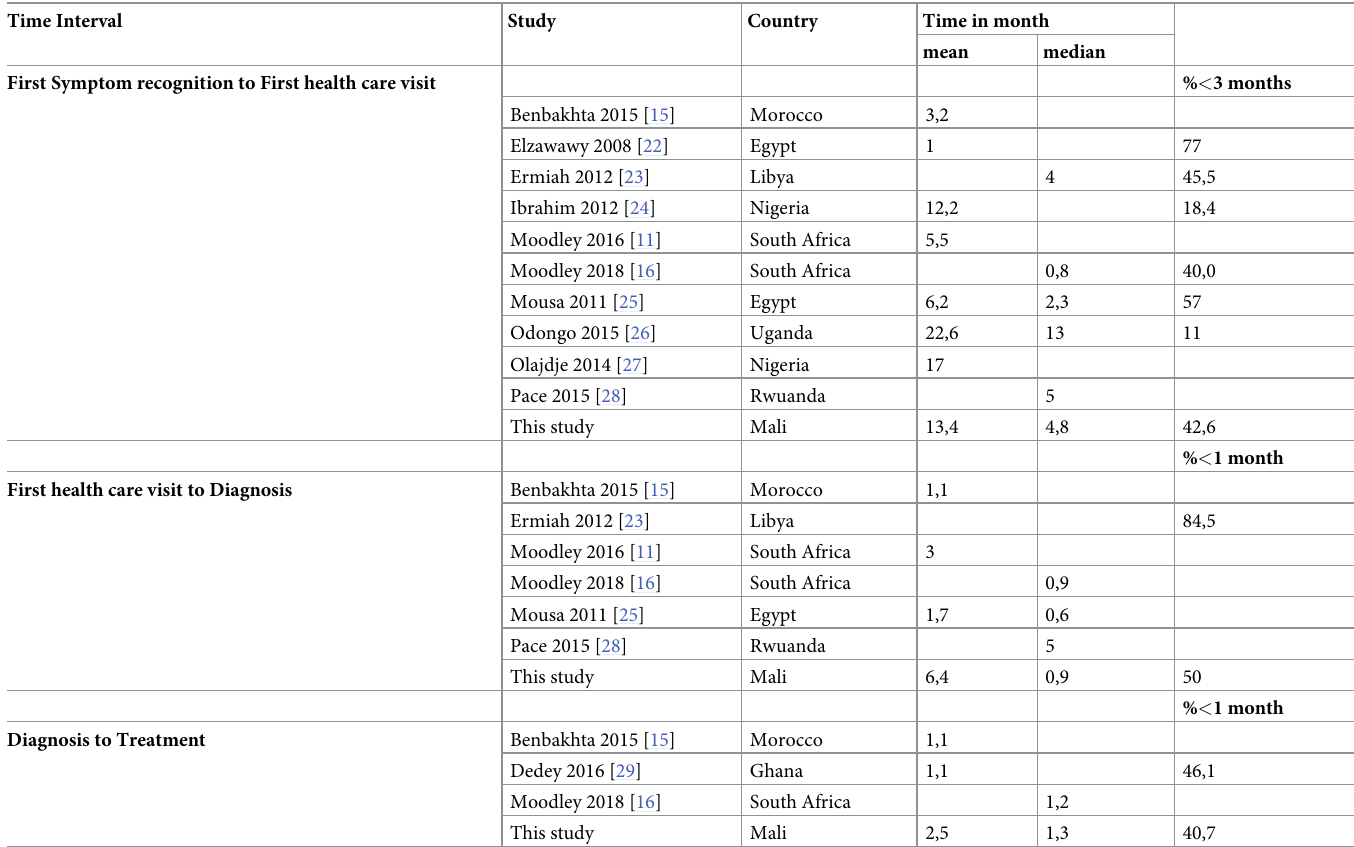
Table 3. Comparisons of time to first health care visit, diagnosis and treatment reported in studies from Africa. Time